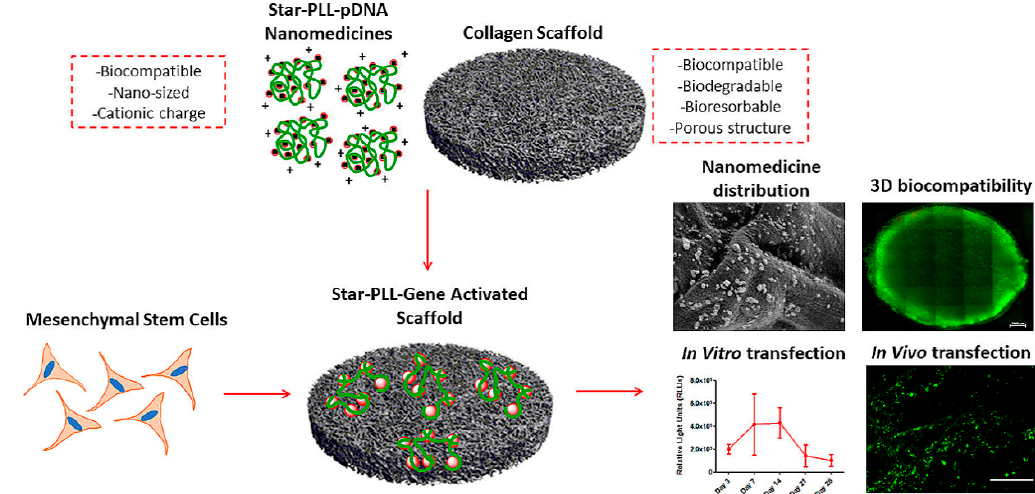
Figure 9. Schematic illustration and SEM micrograph of the incorporated star -shaped PLL/pDNA peptiplexes into collagen-based scaffold platform and in vivo transfection of autologous host cells with star-PLL/pDNA scaffold, showing prolonged, non-toxic transgene expression. Seven days post implantation, gene activated scaffolds demonstrated successful transfection of autologous host cells, as evidenced by the presence of GFP positive (green) cells. Adapted from [132], with permission. Copyright: 2019 Elsevier.